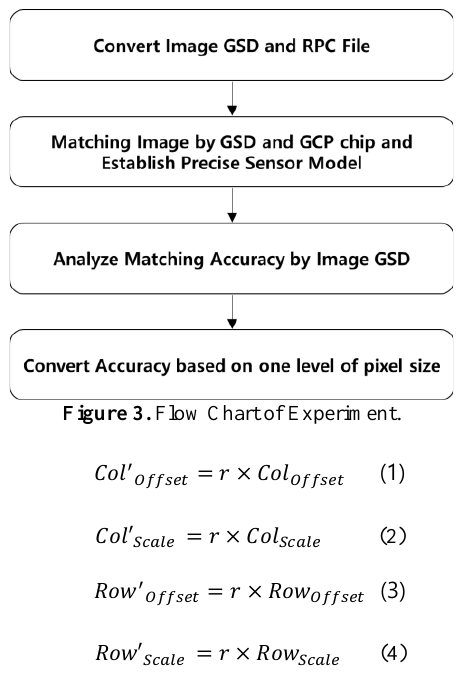
Figure 3. Flow Chart of Experiment.